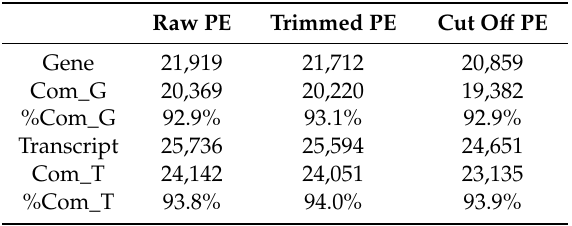
Table 8. Completeness of predicted genes and transcripts in three PLATANUS-assembled genomes based on the presence of start and stop codons. Com_G indicates complete predicted genes. Com_T indicates complete predicted transcripts. %Com_G indicates the percentage of predicted genes is complete. %Com_T indicates the percentage of predicted transcripts is complete.